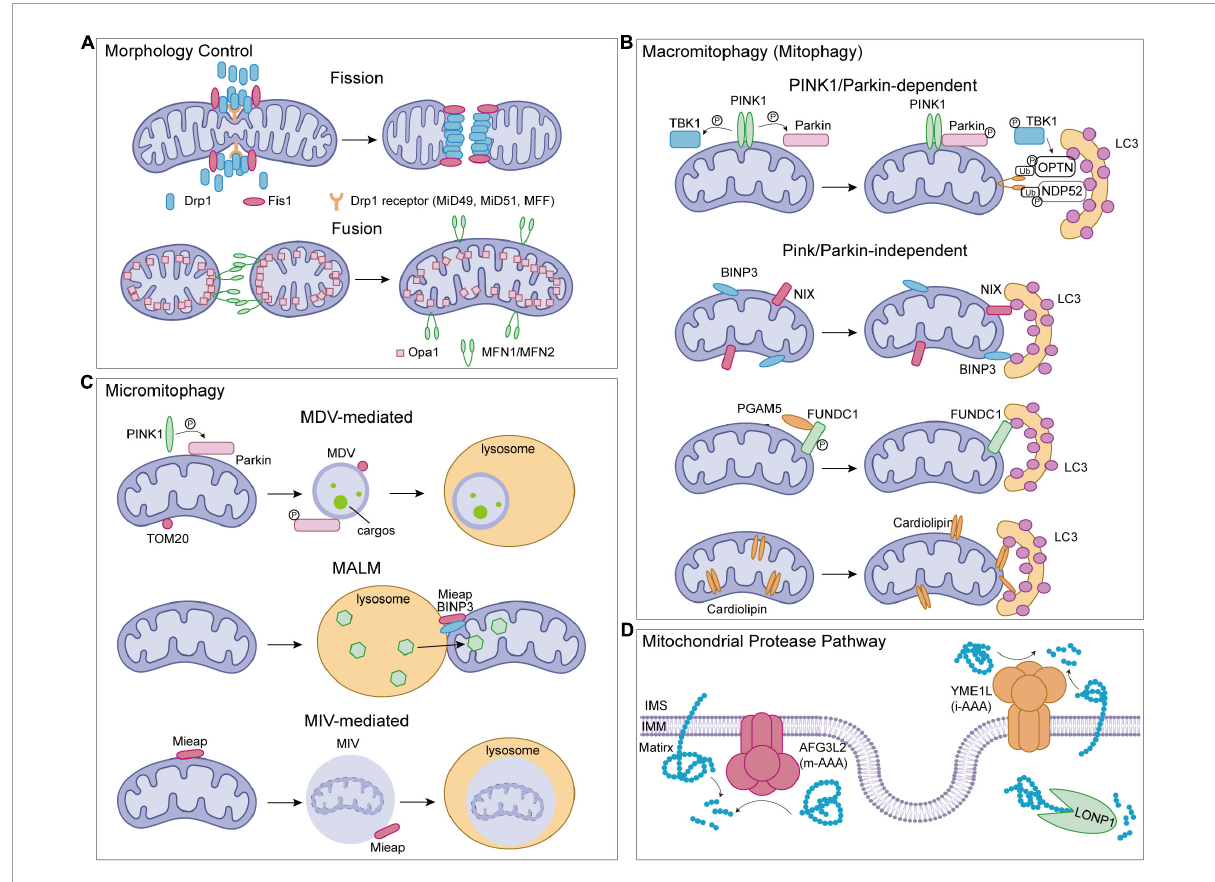
FIGURE2 Mitochondrial quality control (MQC) pathways in human. (A) Mitochondrial morphology control. (B) Mitophagy pathways. (C) Micromitophagy pathways. (D) Mitochondrial protease pathways. Drp1, dynamic-related protein 1; Fis1, fission 1; MFF, mitochondrial fission factor; MiD49/MiD51, mitochondrial dynamics proteins 49/51; OPA1, optic atrophy 1; MFN1/MFN2, mitofusin1/mitofusin2; PINK1, serine/threonine-protein kinase PINK1; Parkin, E3 ubiquitin-protein ligase parkin; LC3, microtubule-associated protein light chain 3; TBK1, TANK binding kinase 1; NIX, NIP3-like protein X; BNIP3, Bcl-2/adenovirus E1B 19 kDa interacting protein 3; FUNDC1, FUN14 domain containing 1; PGAM5, phosphoglycerate mutase family member 5 phosphatase; Mieap, spermatogenesis-associated protein 18; TOM20, translocase of outer mitochondrial membrane 20; MDV, mitochondrial-derived vesicles; MALM, Mieap-induced accumulation of lysosome-like organelles within mitochondria; MIV, Mieap-induced